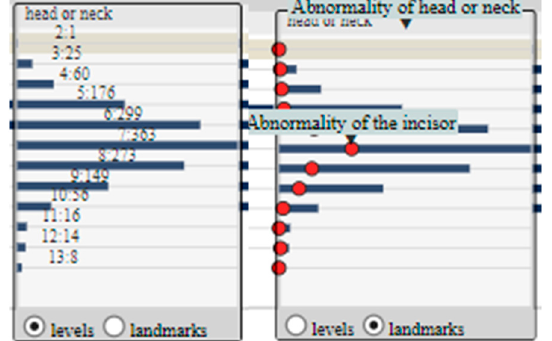
Figure 12. A depiction of the magic lens within the Ontology Sections Panel. We have designed an interaction to occur when users drag the bottom portion of the magic lens horizontally across the ontology sections, which will both refresh the ontology section’s distortion technique and expose information for that section.